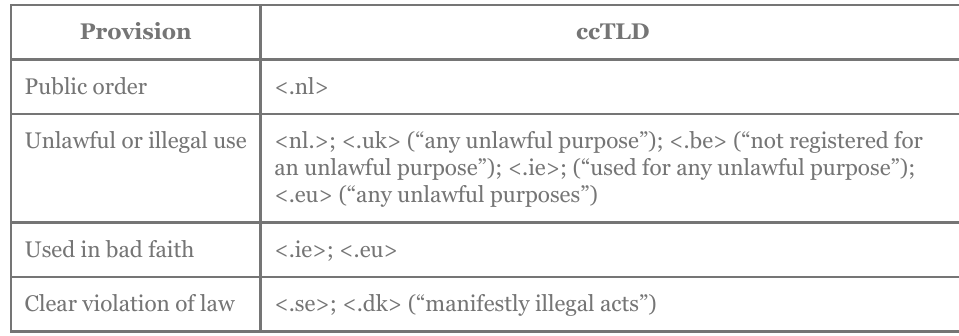
Table 1: Broad provisions addressing use or content